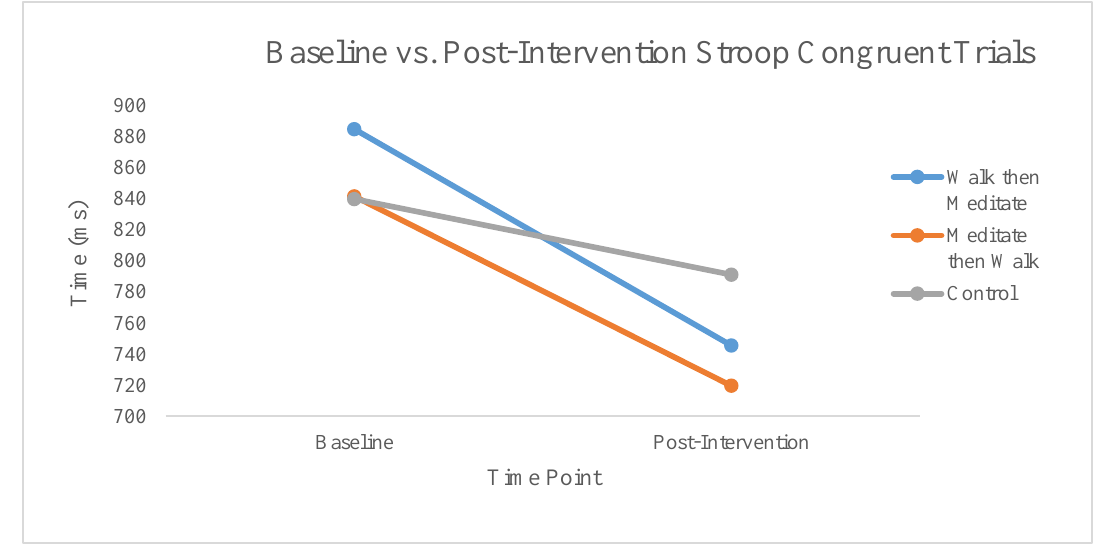
Figure 1. Baseline versus post-intervention Stroop congruent trials.